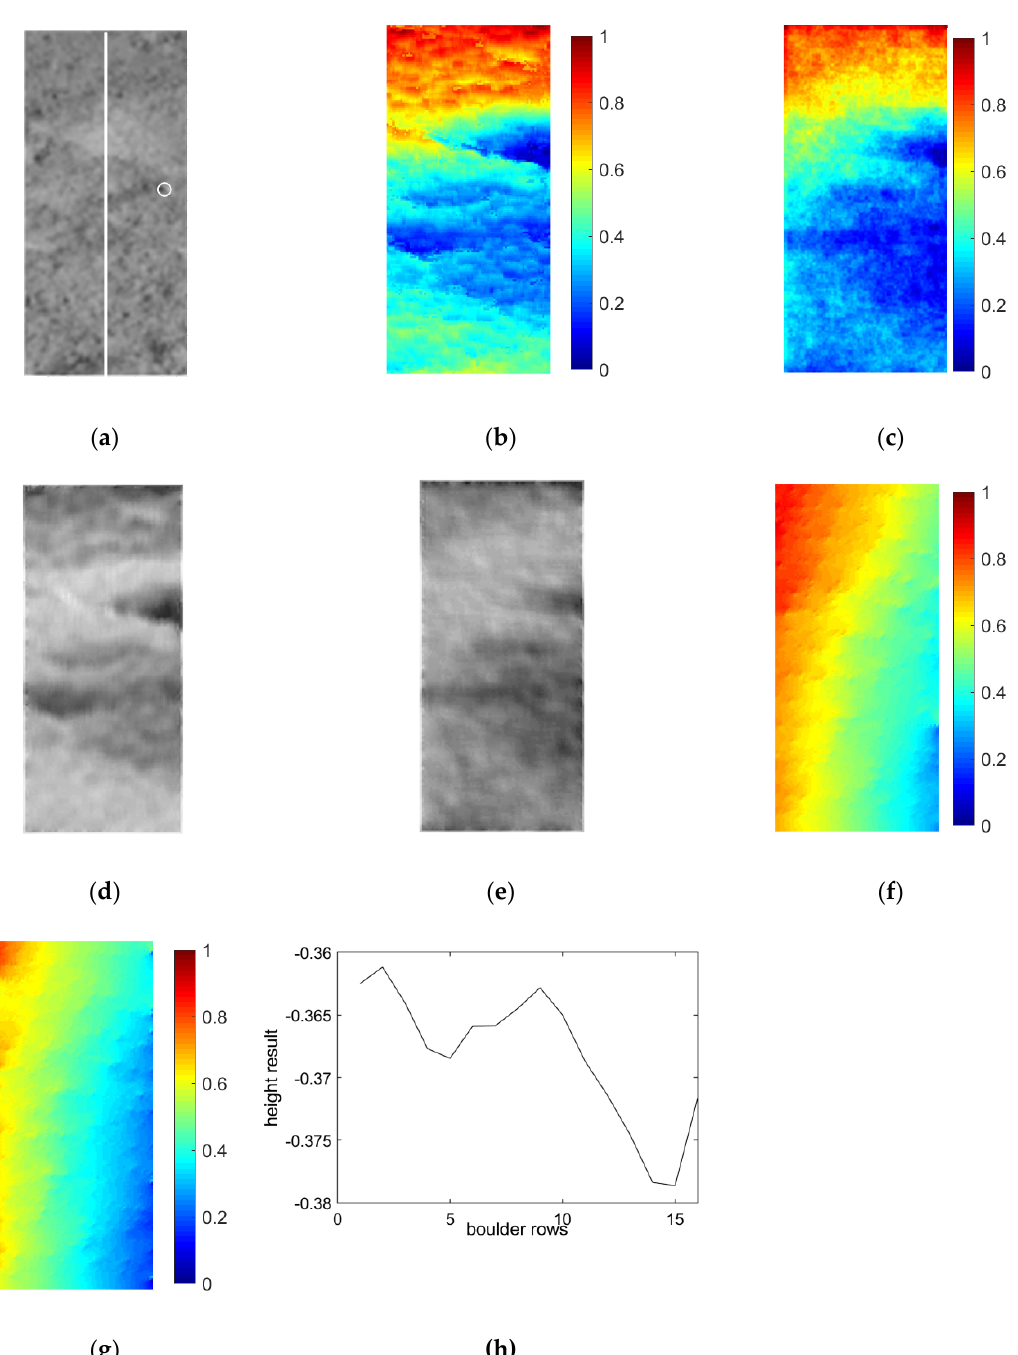
Figure 15. ROI 1 and reconstruction results of the three methods ( a ) ROI 1 image, ( b ) SGM result, ( c ) PPS result, ( d ) shaded SGM result, ( e ) shaded PPS result, ( f ) PSPP result, ( g ) PSOP result, ( h ) Profile of the boulder (marked by the white circle in ( a )) from PPS result.